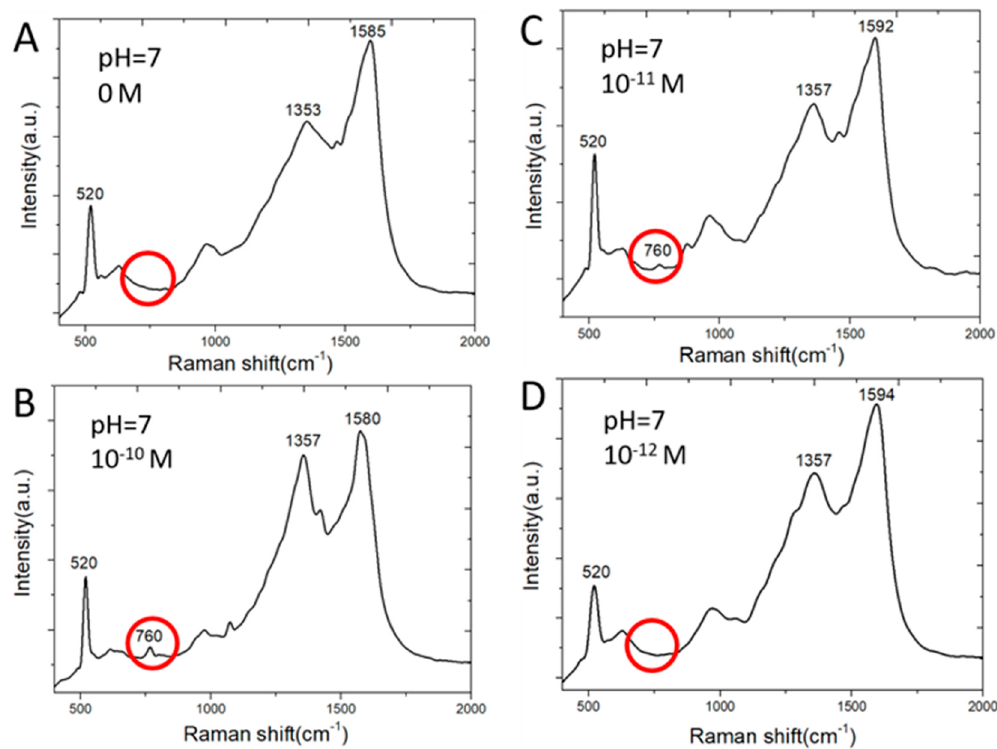
Figure 5. Raman spectra of adenine molecules in water having absorbed on SERS sensor surface: ( A ) 0 M; ( B ) 10 − 10 M; ( C ) 10 − 11 M; ( D ) 10 − 12 M. Table 3. Low Detection Limit of Adenine Using SERS Sensors Made of Silver Nanoparticles Deposited for Di ff erent Length of Time on Ball-like Copper Bumps Formed from 75-nm-thick Copper Films. Silver Deposition Time Adenine 1 min (M) 15